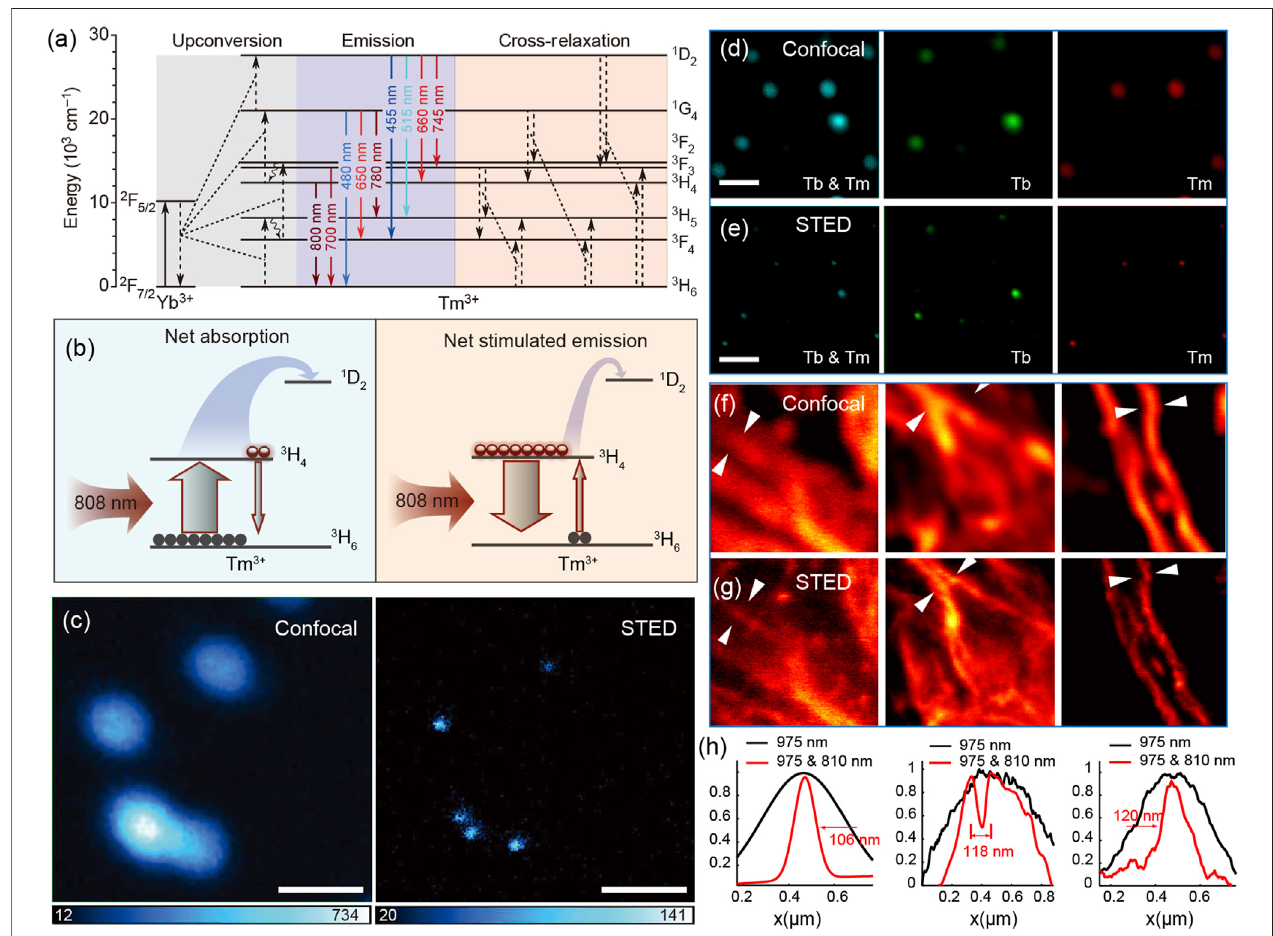
FIGURE2|(A) EnergyleveldiagramandenergytransferpathwaysofYb 3+ /Tm 3+ co-dopednanocrystalsexcitedbya980 nmlaser.Solidarrowsmeanemissions; curvedarrows meanenergy transferfromYb 3+ toTm 3+ and typical cross-relaxationbetweenTm 3+ ions. (B) Simpli fi eddiagramsdescribing netabsorption (left) and net stimulatedemission (right) betweenexcitedstate 3 H 4 andgroundstate 3 H 6 ofTm 3+ ionsundera980-nmlaserexcitation. (C) Opticalimagingof40 nm8%Tm 3+ -doped nanocrystals based on confocal and STED microscopy, demonstrating the practicability of lanthanide-doped nanocrystals on super-resolution imaging. Adapted with permissions from the study by Liu et al. (2017) (scale bars, 500 nm). (D) Confocal and (E) super-resolution fl uorescence images of NaGdF 4 :40%Yb 3+ ,10% Tm 3+ @ NaGdF 4 :15%Tb 3+ nanocrystals with the emission wavelength at 455 and 547 nm (left) , 547 nm (middle) , and 455 nm (right) . (F) Confocal and (G) super-resolution fl uorescenceimagesofthecellularcytoskeletonproteindesminconjugatedwithTm 3+ -dopednanocrystals. (H) Linepro fi lestakenfrom (F) and (G) quantitativelyindicate the improvement of optical resolution of STED nanoscopy. Adapted with permissions from the study by Zhan et al. (2017).